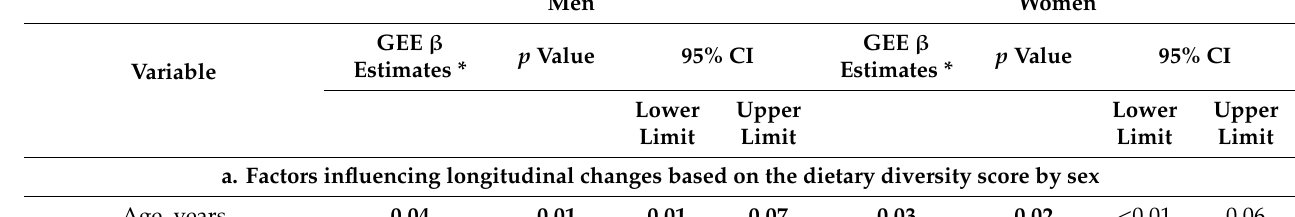
Table 3. Factors influencing longitudinal changes based on the dietary diversity score and the Diet Quality Index-International by sex. Men Women GEE β GEE β p Value 95% CI p Value 95% CI Estimates * Estimates * Variable Lower Upper Lower Upper Limit Limit Limit Limit a. Factors influencing longitudinal changes based on the dietary diversity score by